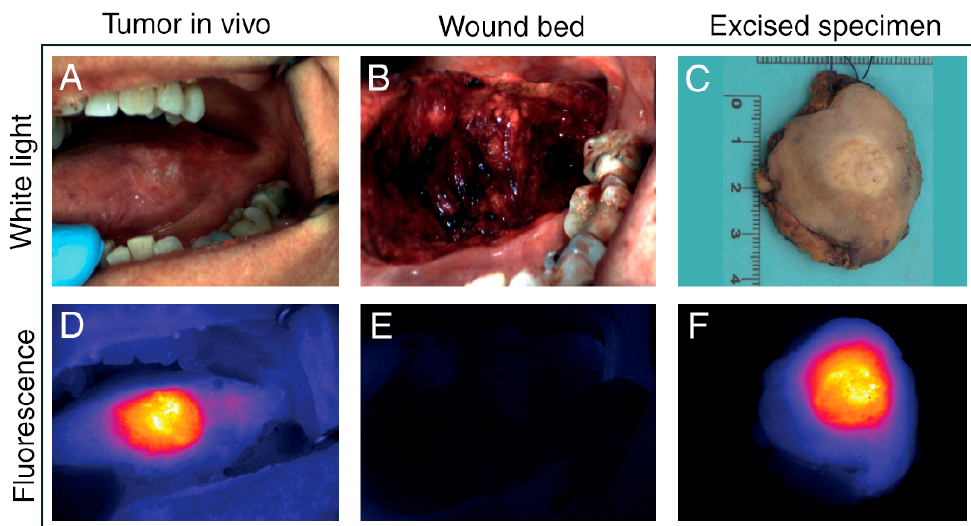
Figure 4. Fluorescence imaging using pH-activatable nanoprobe ONM-100 in head and neck squamous cell carcinoma of the tongue. In vivo ( A , B , D , E ) and ex vivo ( C , F ) visualization of high fluorescence signal in the tumor and low fluorescence signal in tumor-free margin and wound bed. Adapted and reproduced from Voskuil et al. (CC BY 4.0) [67].